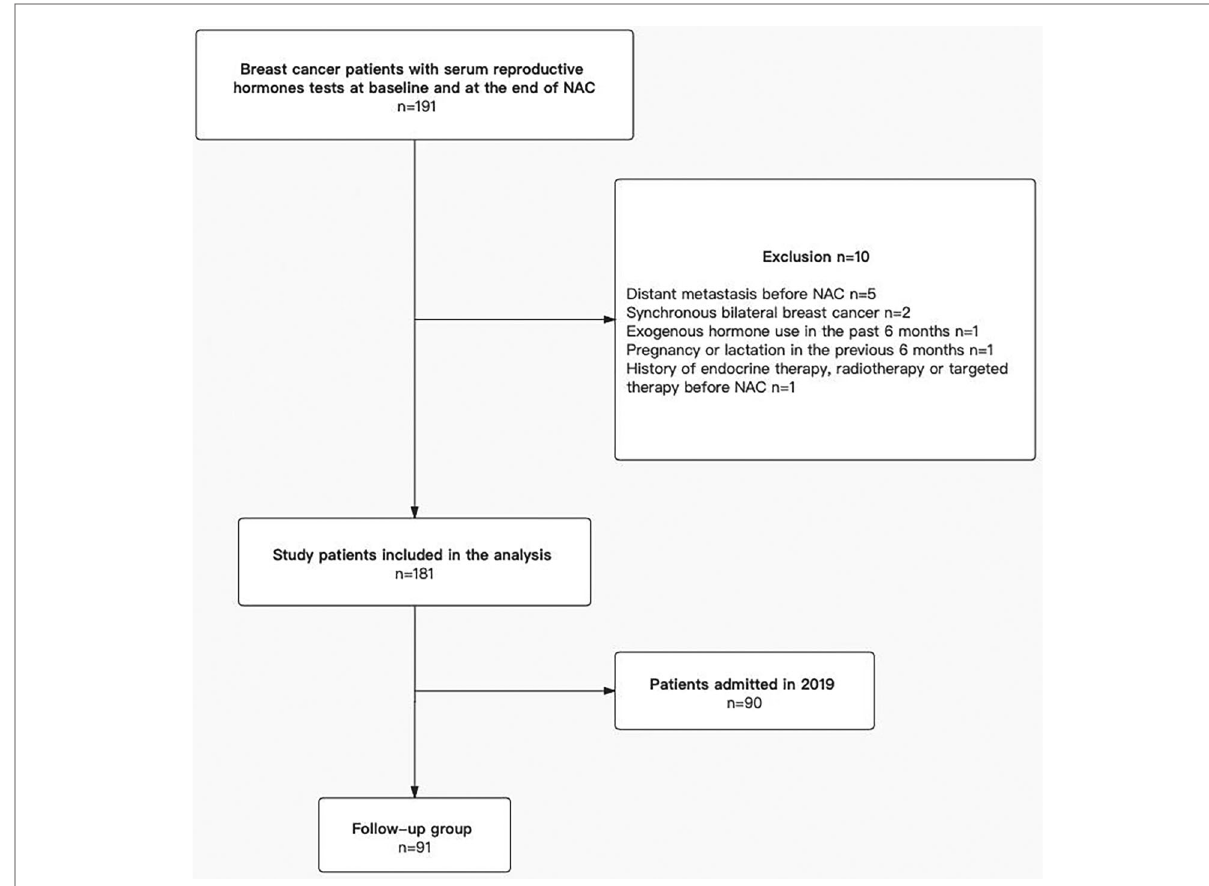
FIGURE 1 Flow chart of the patient selection. After exclusions, the fi nal sample size was 181 patients, and a total of 91 patients were enrolled in the follow-up group. NAC, neoadjuvant